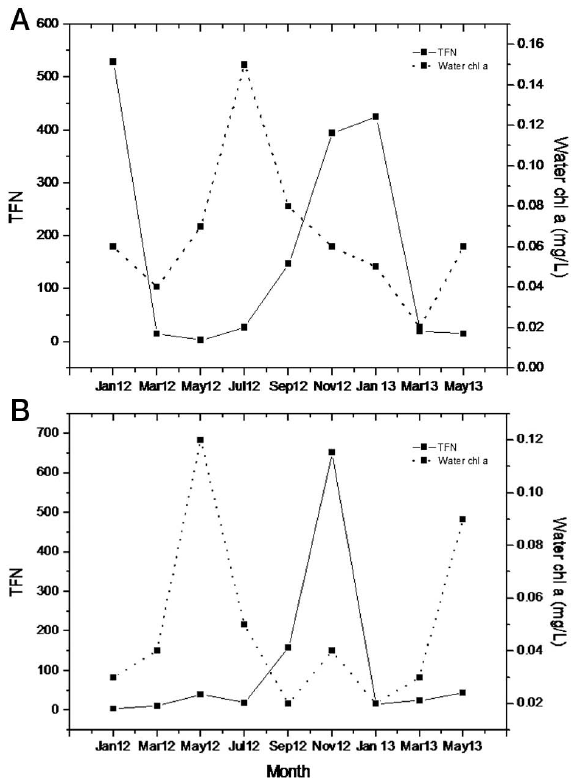
10. – Seasonal variations in water chlorophyll a and total fo- raminiferal number (TFN/g) at Site 1 (A), Payyannur (PNR) and Site 2 (B), Panambur (PNBR).